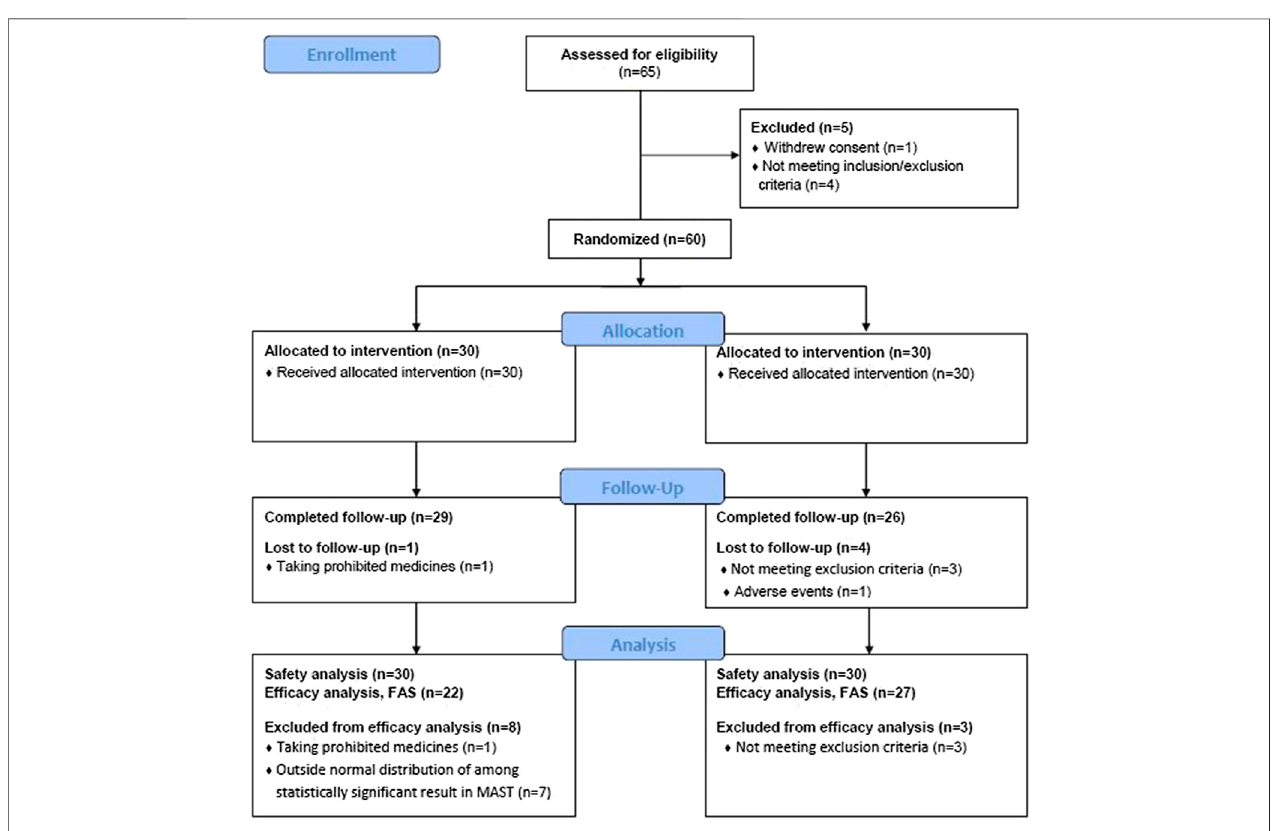
FIGURE 1 | Study fl ow chart describing the randomized controlled